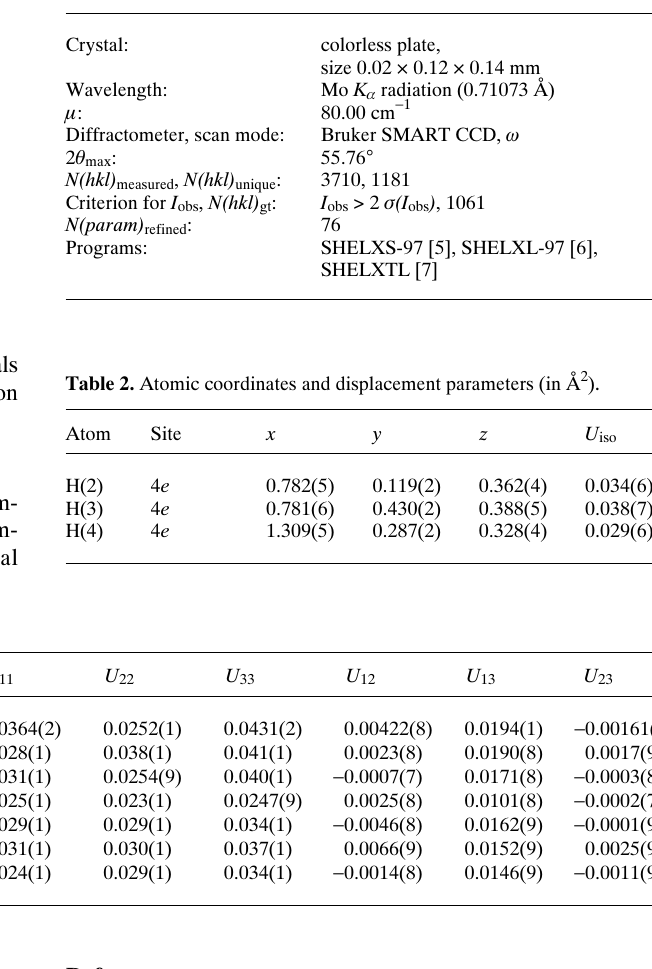
Table 1. Datacollection and handling.